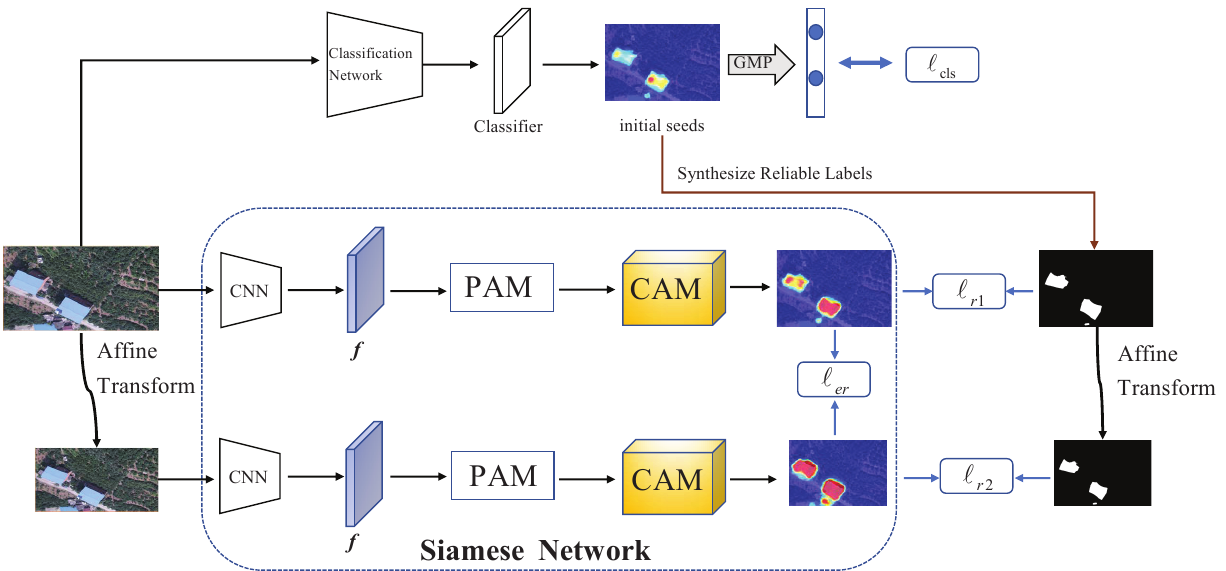
Figure 2. Our proposed RSPA framework is based on a Siamese network. First, the initial seeds are obtained through the classification network, which are then used to synthesize reliable labels. PAM can further mine more discriminative regions to obtain modified CAMs. The RSPA is the integration of PAM and reliable label supervision. GMP denotes Global Max Pooling. The affine transformation is